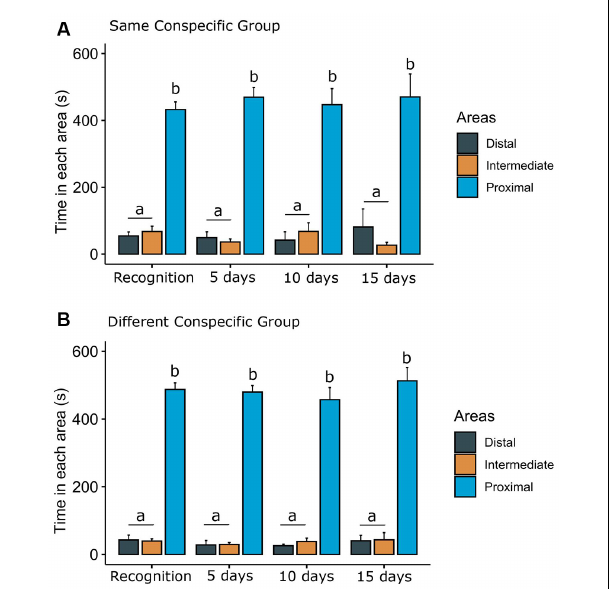
FIGURE 5 | Time spent in each area of the tank. Bars (Mean + SE) indicate the time that the dusky damselfish Stegastes fuscus spent in each area of the tank for (A) the same conspecific group or (B) different conspecific group. The tank was divided into three virtual areas (proximal, intermediate, and distal). Two-way ANOVA showed that both animals visually exposed to the same and different conspecifics spent more time in the proximal area: different lower case letters indicate statistical significance ( p =